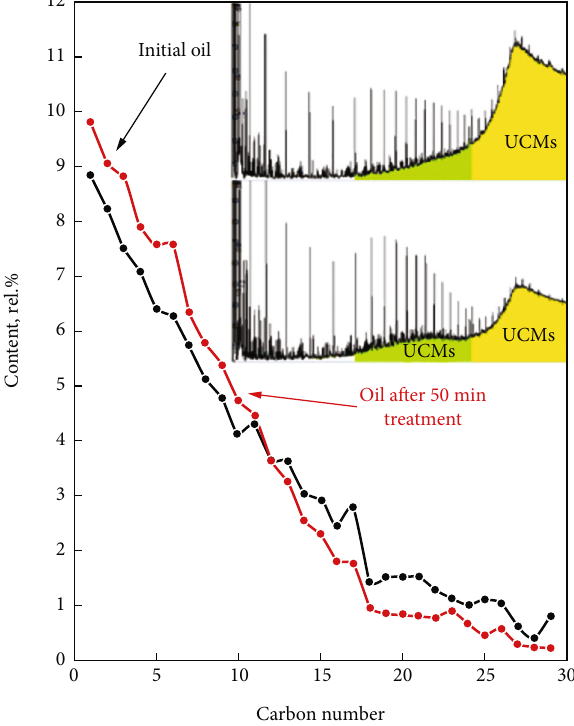
Figure 4: A composition of the saturated fraction according to GCMS data for the original oil and oil after 50 min exposure. The inset indicates chromatograms showing naphthene “ humps ”